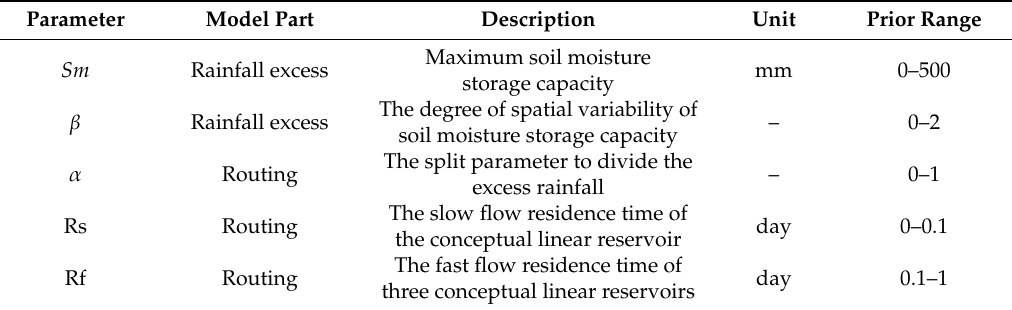
Table 2. Description and prior uncertainty ranges of the Hymod model